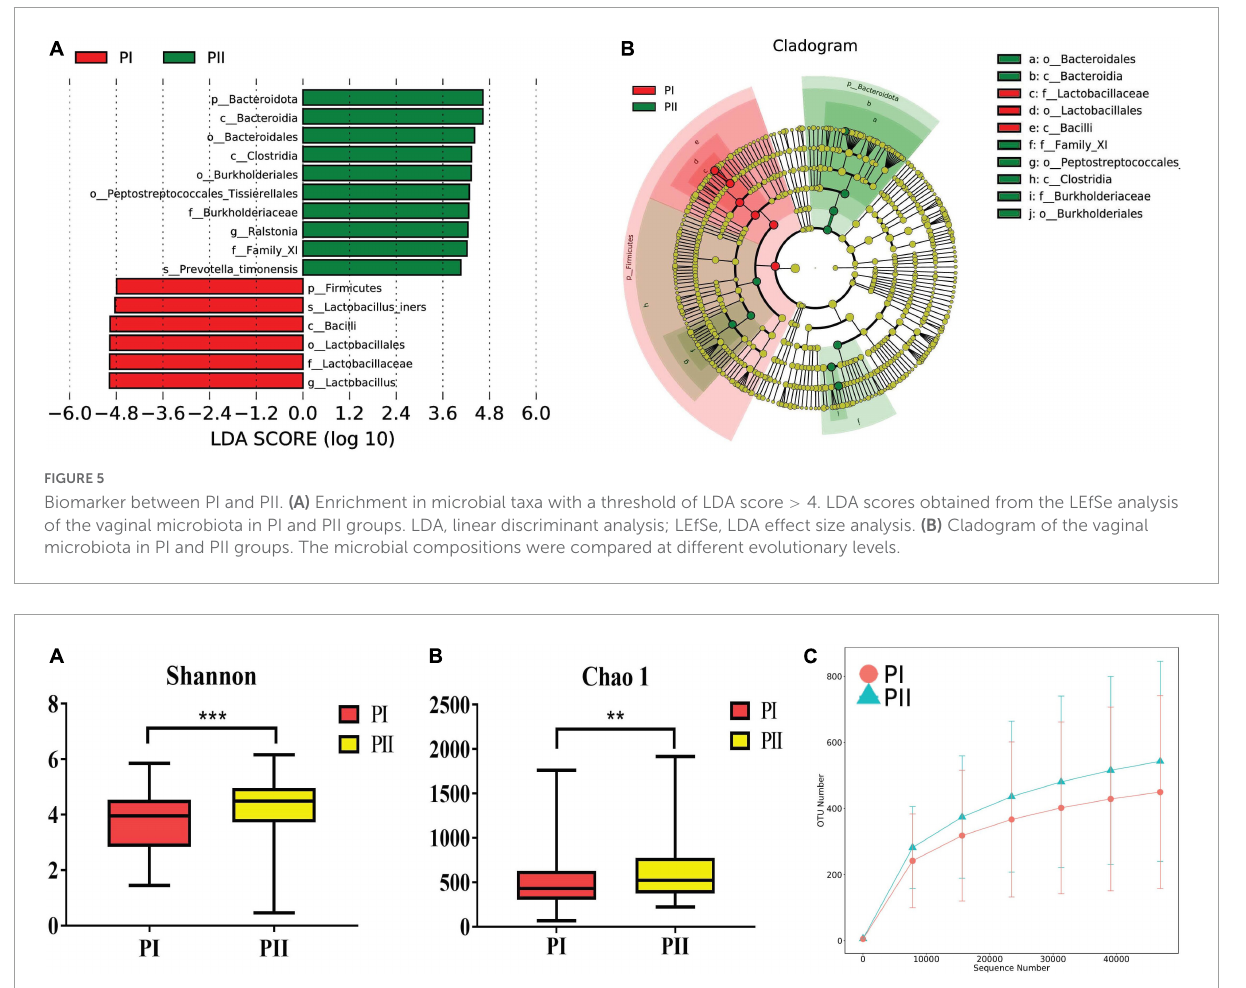
FIGURE6 Diversity of the vaginal microbiota between PI and PII. (A) Boxplots of the Alpha diversity with Shannon index. (B) Boxplots of the Alpha diversity with Chao1 index. ** P < 0.01, *** P < 0.001, two-sided Wilcoxon test. Bounds of boxes showed interquartile range (IQR) with the lower and upper hinges corresponding to the 25th and 75th percentiles, respectively. (C) Rarefaction curve showed the OTU numbers increased more with enlargement of sequence numbers in PII